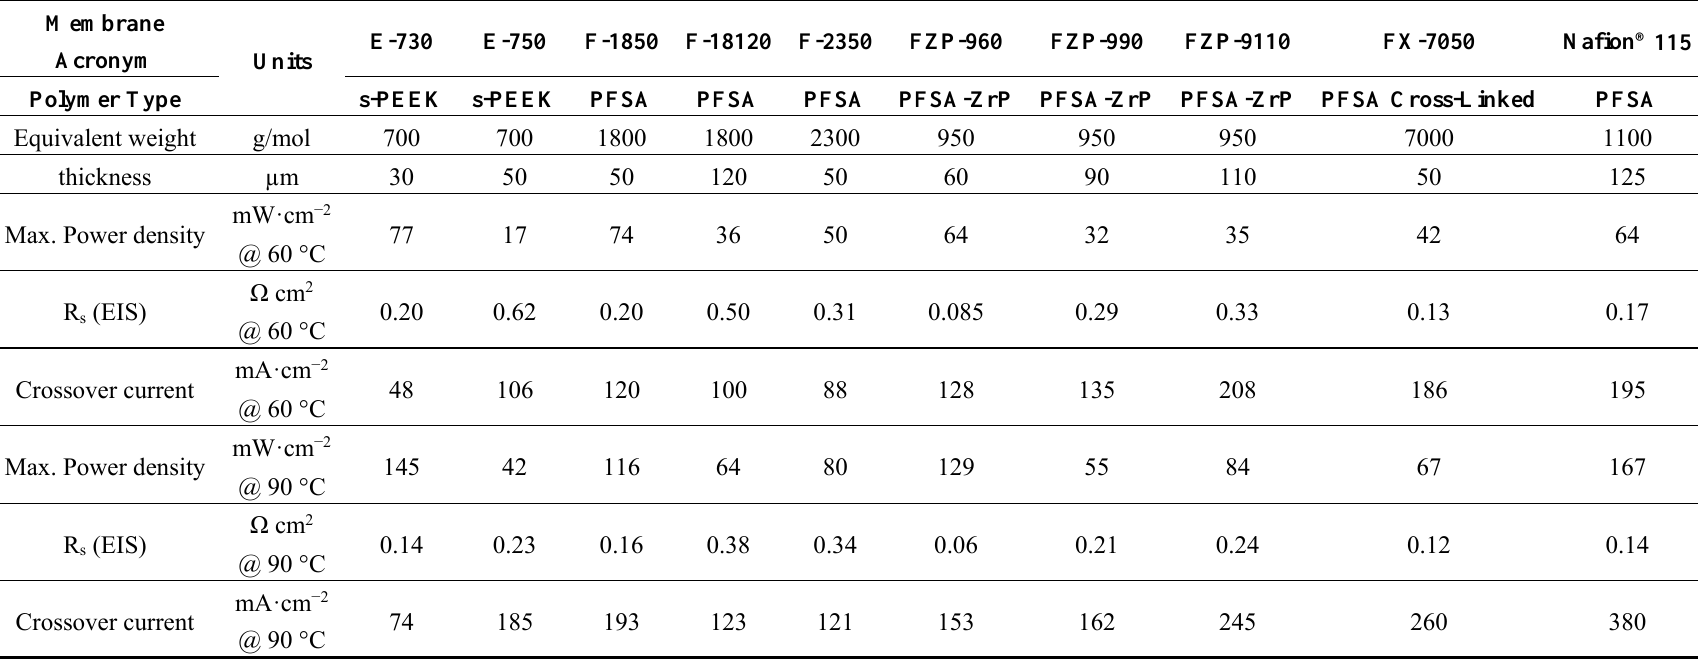
Table 2. Electrochemical characteristics of the membranes in DMFC (2M CH 3